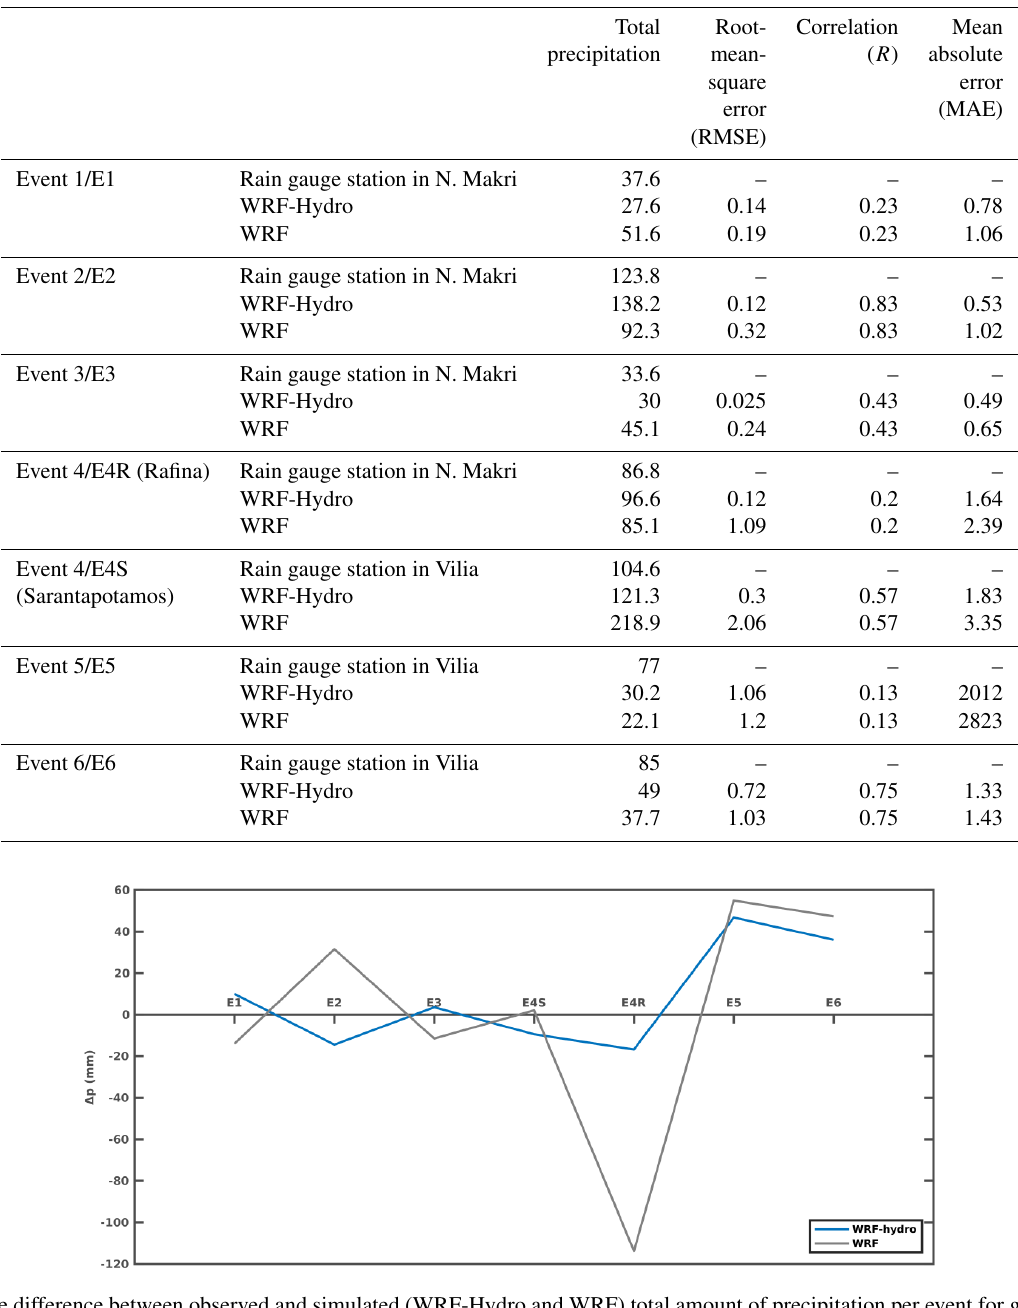
Table 6. Comparison of total amount of observed precipitation to WRF-Hydro and WRF-only simulated precipitation for each event for the gauge stations in Vilia and N. Makri. RMSE, R , and MAE are calculated on hourly values of precipitation.